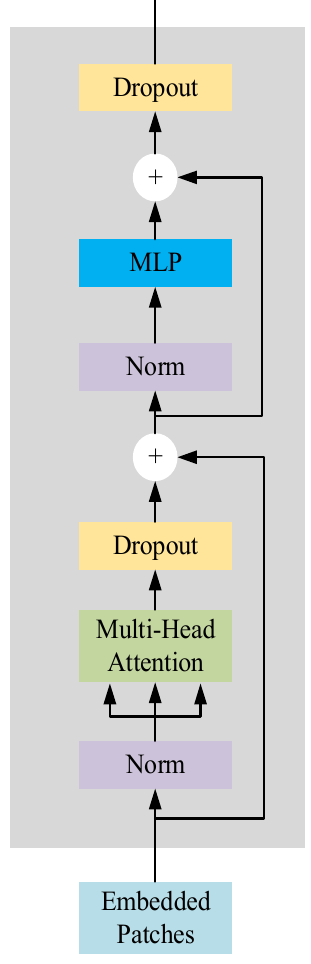
Figure 4. Vision transformer encoder module.